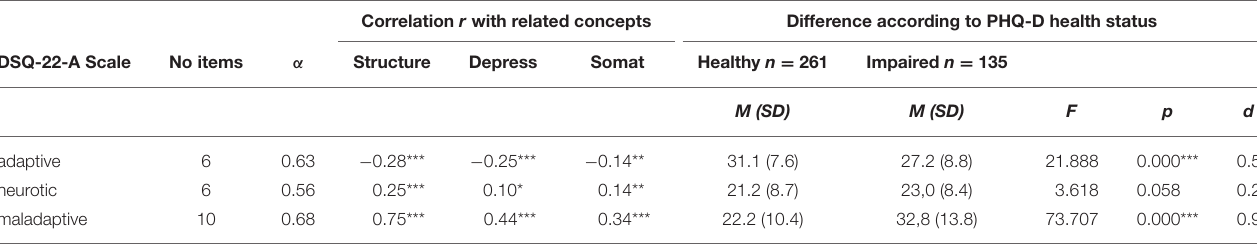
TABLE 4 | Basic psychometric properties of the DSQ-22-A scales, reliabilities Cronbach’s Alpha ( α ), Pearson correlation ( r ) with related scales, effect size Cohen’s d of group differences in ANOVA. Correlation r with related concepts Difference according to PHQ-D health status DSQ-22-A Scale Structure Depress